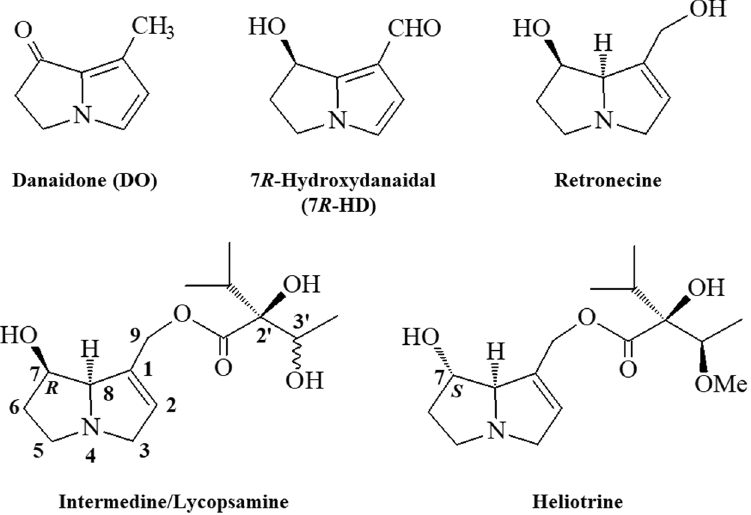
Figure 1. Chemical structures of the sex pheromone components of Parantica sita males and PAs that were orally administered to the males. A mixture of danaidone (DO, major) and 7 R -hydroxydanaidal (7 R -HD) constitutes the male sex pheromone of the butterfly. The stereochemistry at C3’ of intermedine and lycopsamine is R and S ,